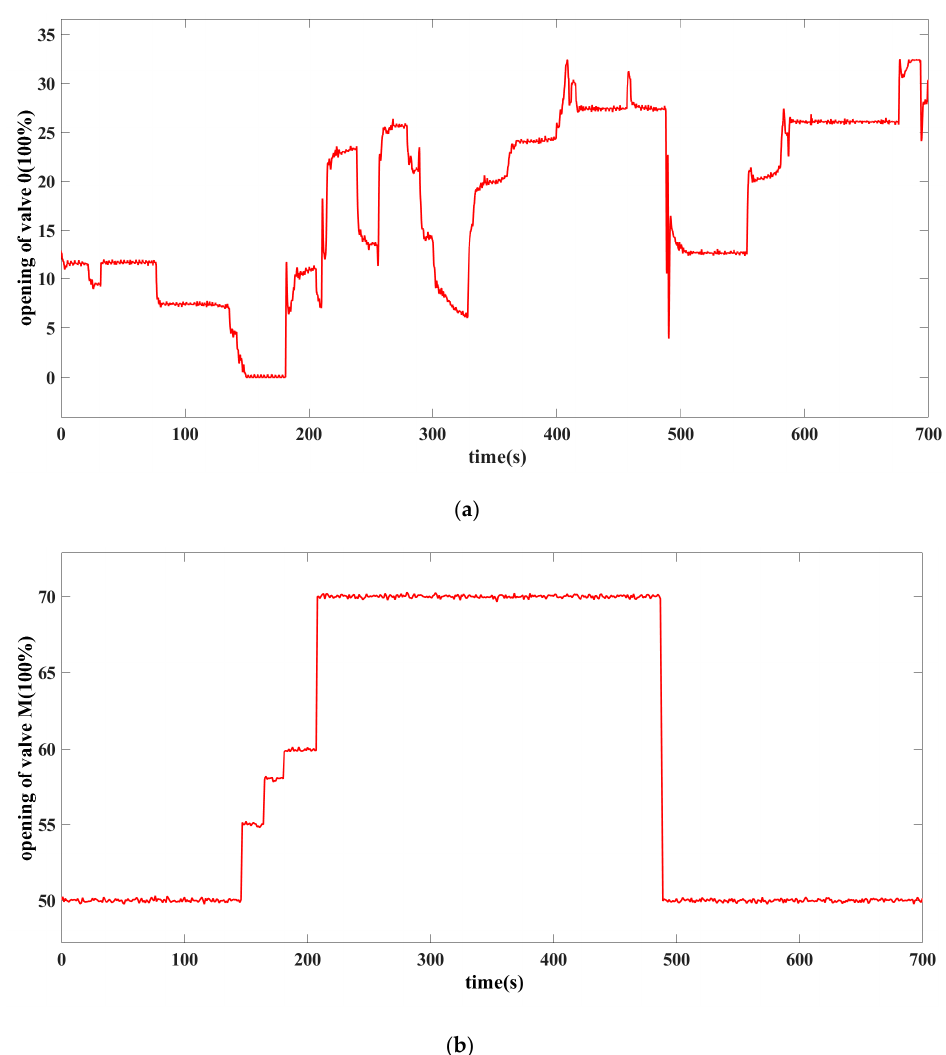
Figure 3. The schematic diagram of the MDSG model of an air suction parallel compression sys- tem.